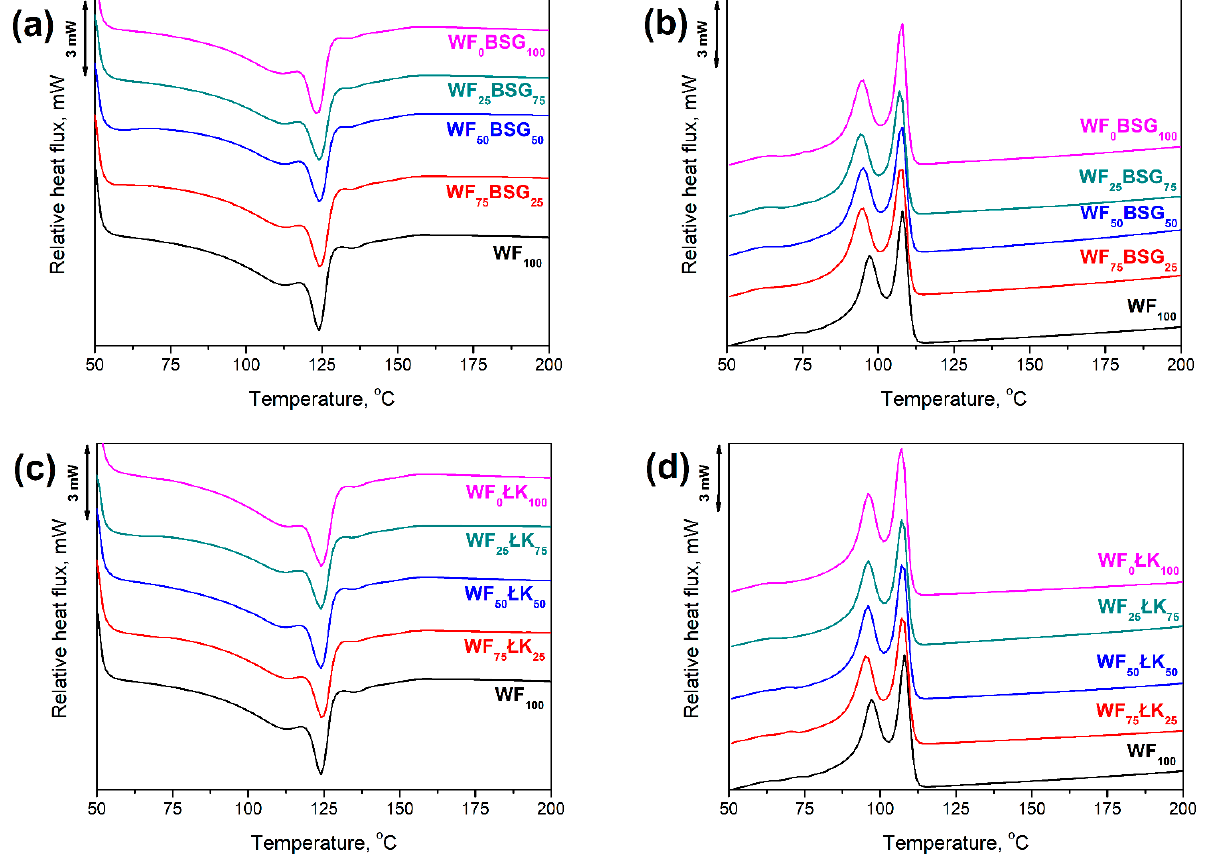
Figure 9. Thermograms obtained for ( a , c ) heating and ( b , d ) cooling of prepared composites.